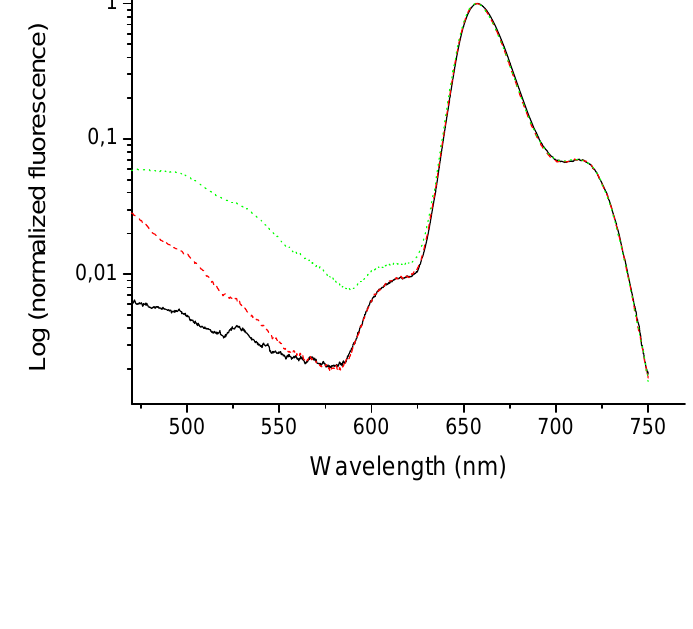
Figure 5. Emission spectra (logarithmic scale) of Acetonide-G0-prop-TPPH Acetonide-G3-prop-TPPH (dashed/red), and Acetonide-G5-prop-TPPH (dotted/green). Concentration 0.010 mM (THF); excitation wavelenth 403 nm. Slits 5 and 10 nm for excitation and emission,